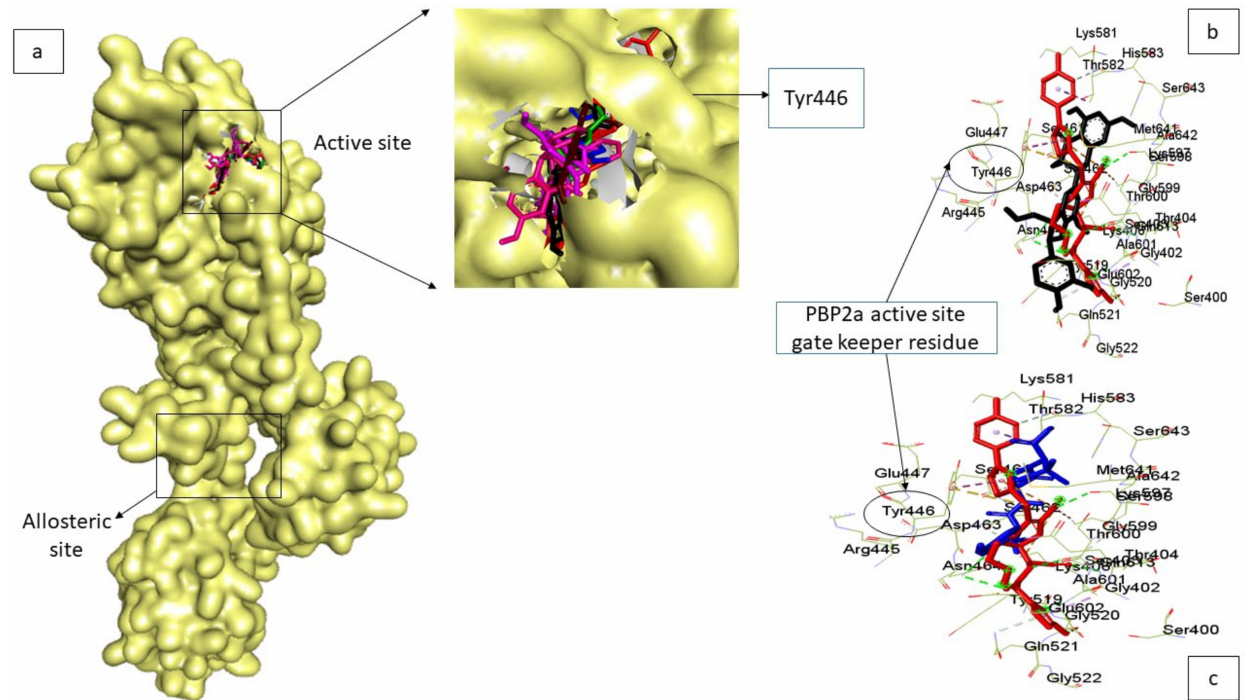
Figure 2. Validation of docking technique and parameters via the redocking approach against the co-crystal structure of PBP2a from S. aureus (3ZFZ). ( a ) the superimposition showed that the top-five phenolics (chroman-4-one (green), epicatechin gallate (purple), epigallocatechin 4-benzylthioether (brown), propan-2-one (pink), silicristin (black) and amoxicillin (blue)) could achieve the same orientation with the native inhibitor (red) of 3ZFZ with a low RMSD value of <1. ( b , c ) showed the superimposition of silicristin (phenolic with the highest docking score) and amoxicillin (antibiotic with the highest docking score) with the native inhibitor of 3ZFZ, displaying the amino acid at the active site (located 60 Å away from the allosteric site) and the active site gatekeeper residue (Tyr 446)